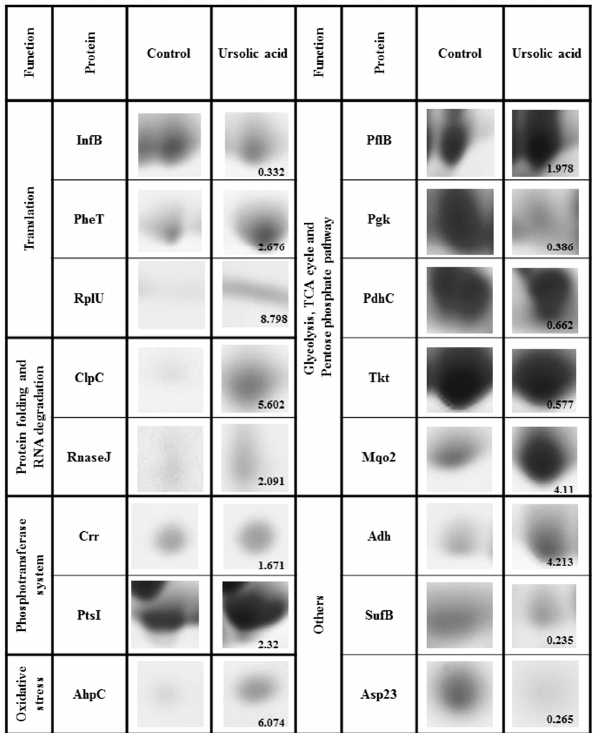
Figure 3. Details of 2D gels depicting 16 specific marker proteins for cell translation, protein folding and RNA degradation, the cell phosphotransferase system, oxidative stress, and the general cell metabolic pathway. Induction or reduction factor is presented in the lower right corner as the average over three replicates.